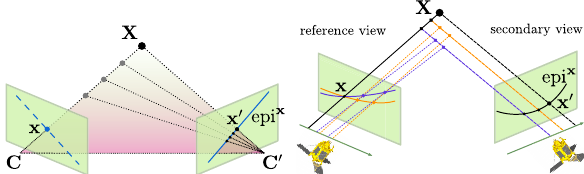
Figure 3: In the pinhole case the epipolar plane defines a cor- respondence between epipolar lines. In the pushbroom case the projection of a 3-space ray on the secondary view generates a ruled quadric. The projection of this quadric on the reference view contains many epipolar curves: epipolar curves are not con-